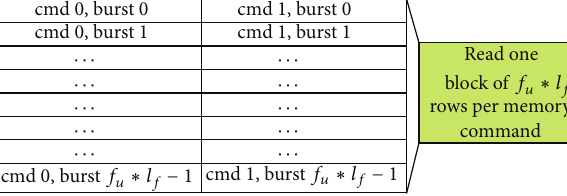
Figure 9: Illustration of compute order for horizontal sums on Convey vector coprocessor. Here, 4 partitions with 256 elements each are